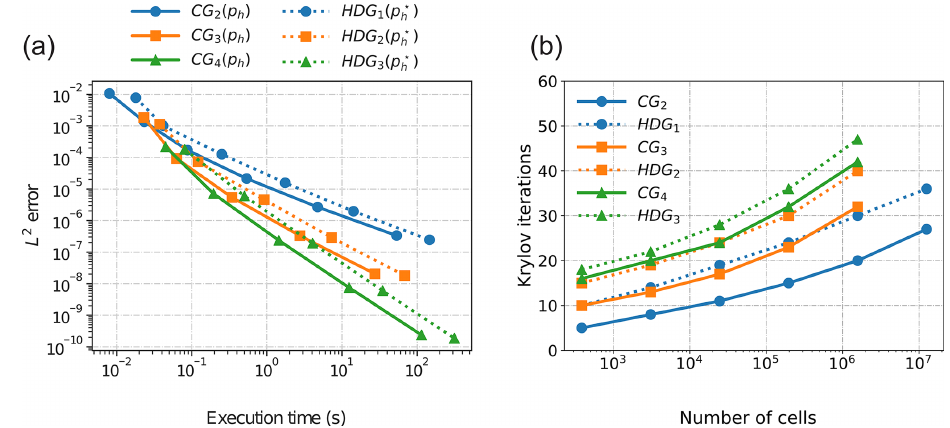
Figure 4. Comparison of continuous Galerkin and LDG-H solvers for the model three-dimensional positive-definite Helmholtz equation. Panel (a) : a log–log plot showing the error against execution time for the CG and HDG with post-processing ( τ = 1) methods. Panel (b) : a log–linear plot showing Krylov iterations of the AMG-preconditioned conjugate gradient algorithm (to reach discretization error) against number of cells. Table 1. Breakdown of the raw timings for the HDG k − 1 ( τ = 1) and CG k methods; k = 2, 3, and 4. Each method corresponds to a mesh size N = 64 on a fully loaded compute